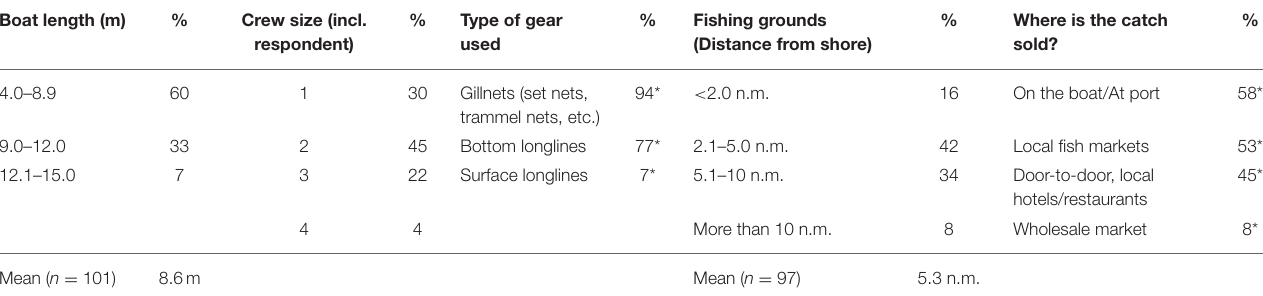
TABLE 2 | Fishing activity characteristics of participants responding to interviews conducted on Crete.